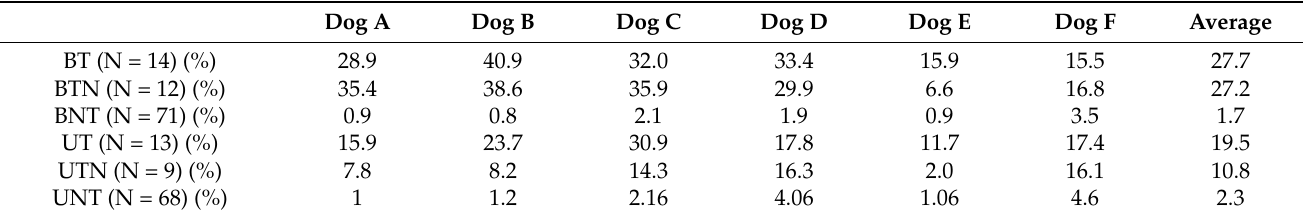
Table 2. The individual and total average lung cancer diagnostic rate of six dogs using lung cancer samples training and then the recognition of exhaled gases and urine samples in lung cancer and non-lung cancer patients groups was compared in the second stage training.